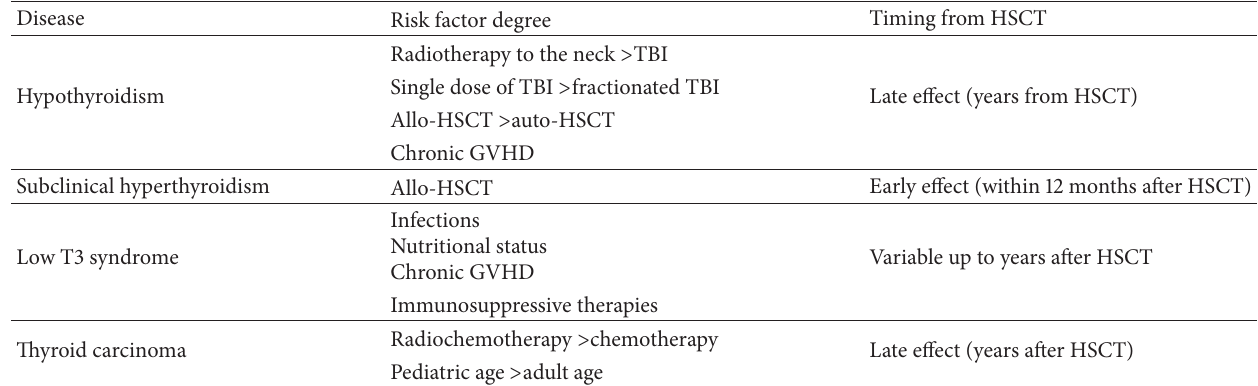
Table 3: Risk factors for thyroid